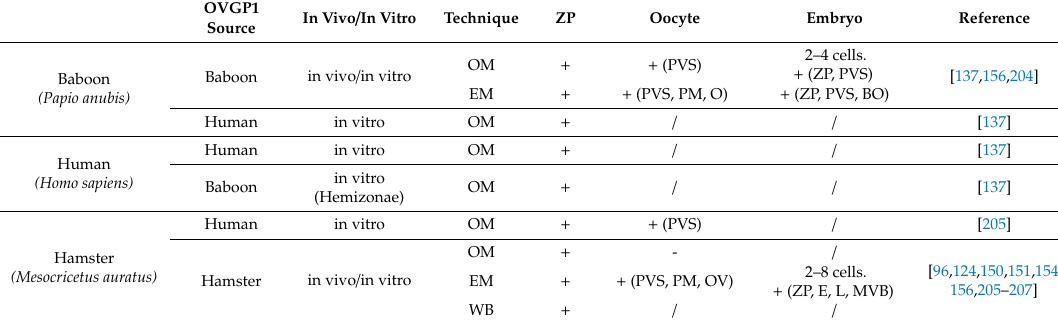
Table 4. OVGP1 protein detected bonded to the zona pellucida (ZP), oocytes and embryos of di ff erent mammalian species. OVGP1 comes from oviductal oocytes (in vivo) or ovarian oocytes exposed to OF, purified protein from oviductal tissue explant or recombinant protein (in